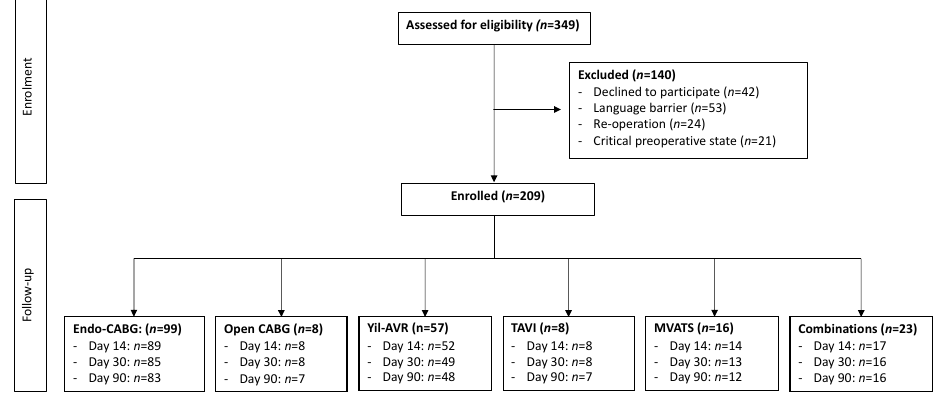
Figure 1. Flowchart of patient recruitment and follow-up. Endo-CABG: endoscopic coronary artery bypass graft; Yil-AVR: endoscopic aortic valve replacement; TAVI: transcatheter aortic valve implantation; MVATS: mitral valve surgery through video-assisted thoracoscopic surgery.